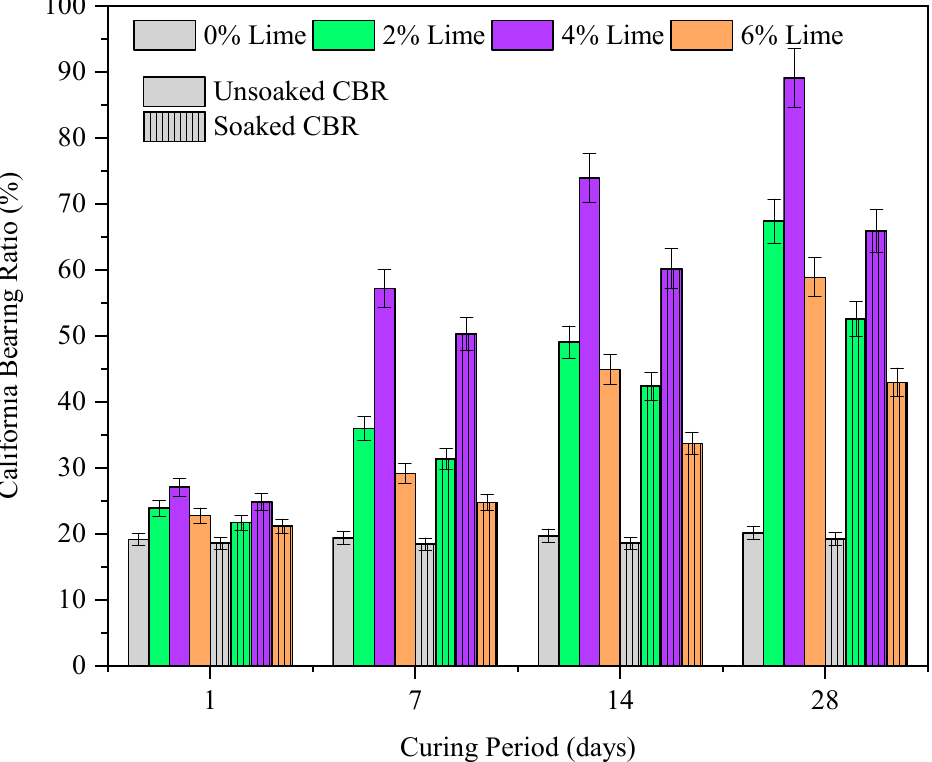
Figure 5. The variation in California bearing ratio of coal gangue with curing period (1, 7, 14, and 28 days) and lime dosage (0 to 6%).